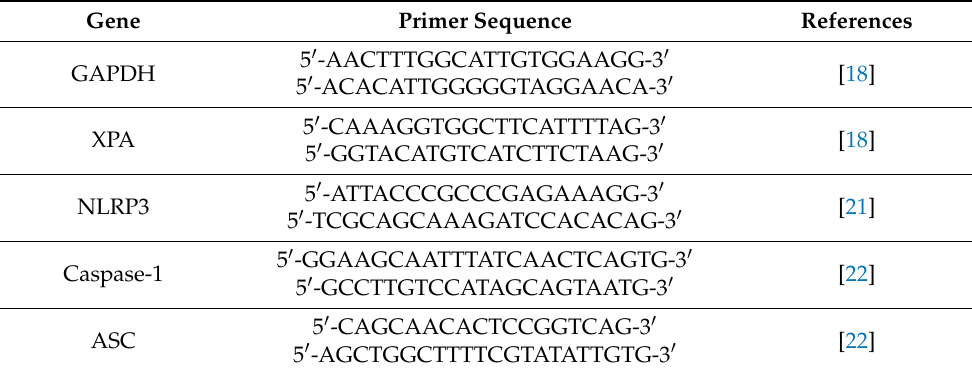
Table 1. Primer sequences used in reverse transcription–polymerase chain reaction. Gene Primer